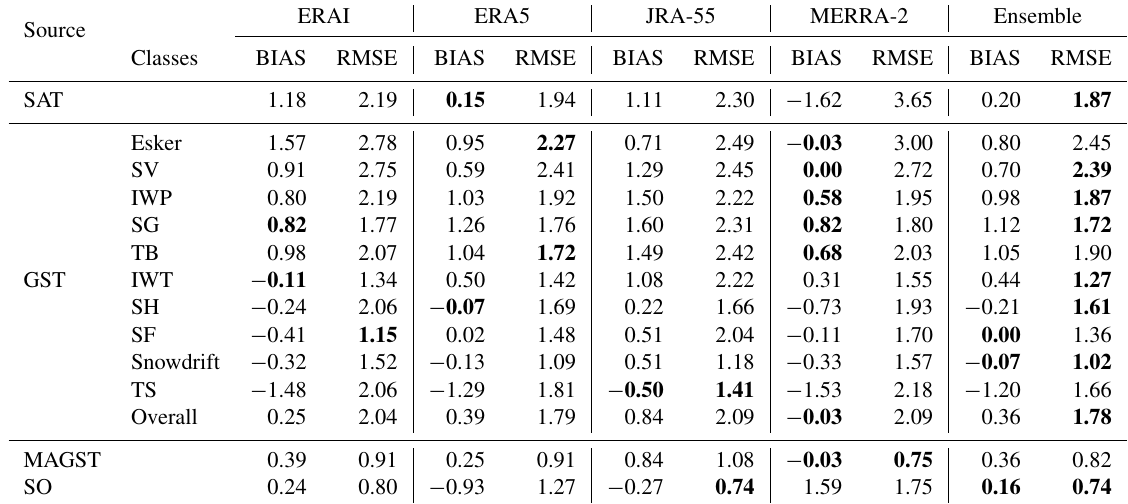
Table 5. Deviance of simulations from the mean of observations within each terrain type. The smallest BIAS and RMSE values for each row are indicated in bold